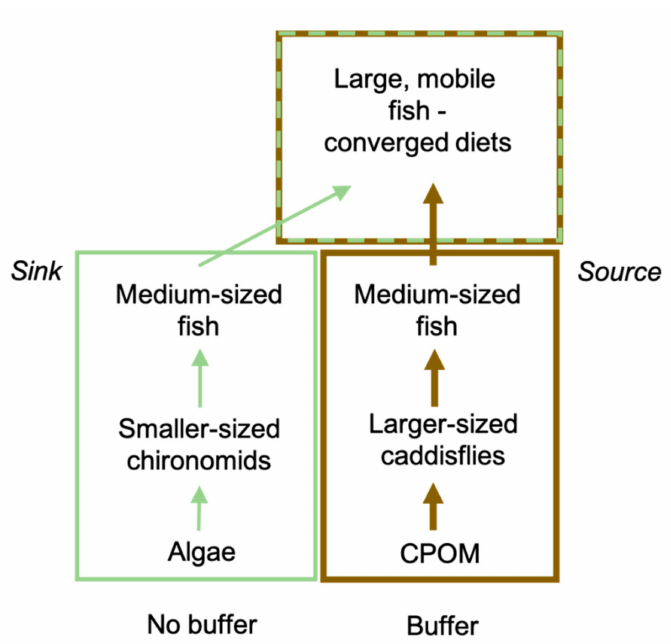
Figure 7. Conceptual model showing the two food web channels to the top: the algal-driven “green” food web channel in unbuffered sites (left) and the “brown” food web channel relying on terrestrial- sourced carbon (right). The peak in abundances of intermediate-sized fish in reaches with forest buffers suggest that buffered sites are a source of fish at this life stage. Larger fish from both site types converged on a diet consistent with detrital and terrestrial food